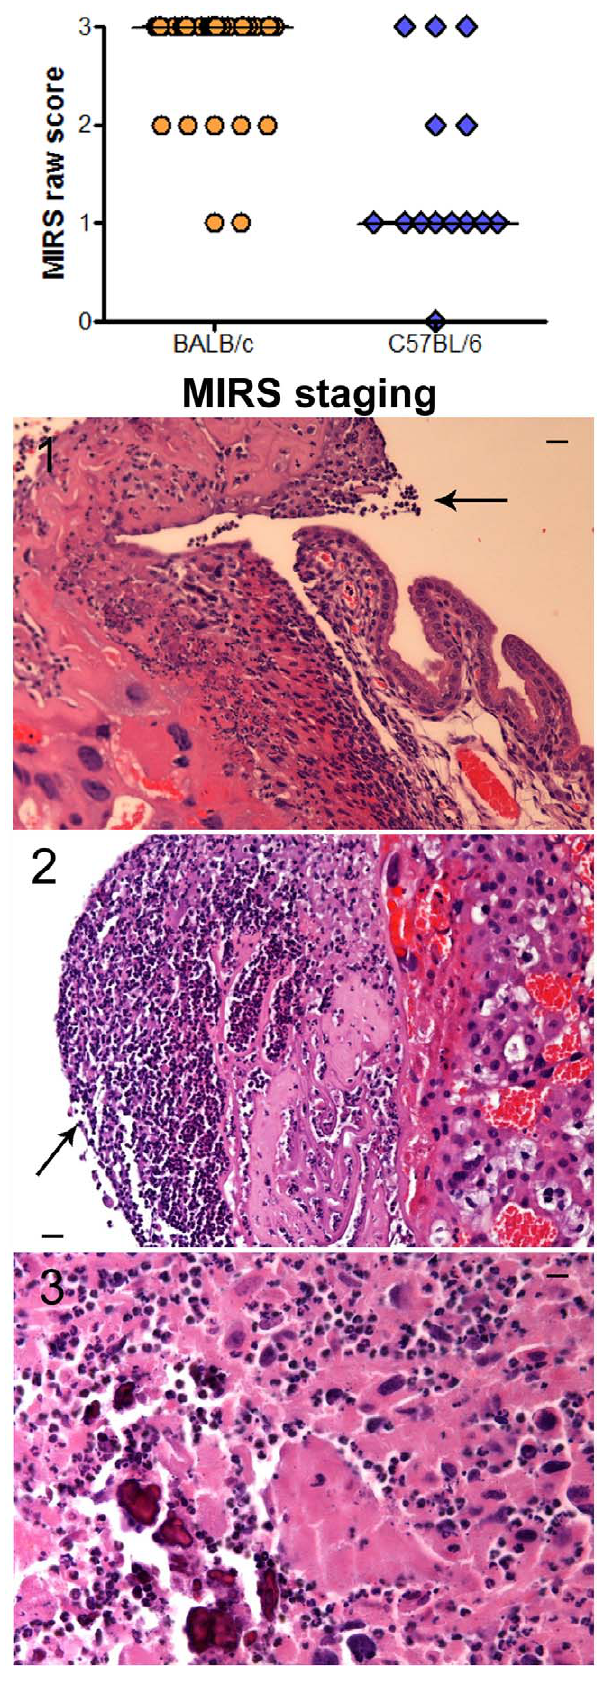
Figure 3. Maternal inflammatory response defined by the degree of chorioamnionitis in U.parvum infected BALB/c and C57BL/6 dams. Distribution of raw maternal inflammatory response (MIR) placental scores using the scoring criteria of Redline et al. [32] summarized in Table 1. Median scores are demarcated with a horizontal line in each graph. Data are a compilation of 3 independent experiments. Accompanying H & E stained photomicrographs of MIRS stages 1–3. Scale bars are equivalent to 100 m m. Arrows are highlighting neutrophilic infiltrates.